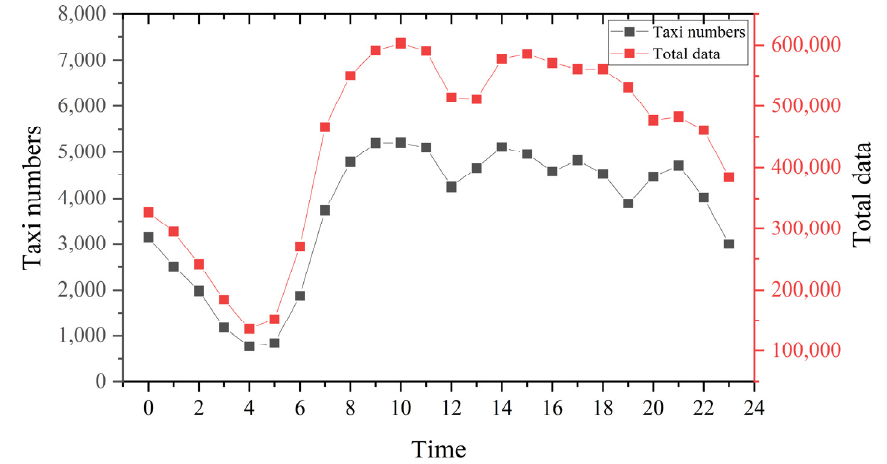
Figure 4. Number of taxis and data volume.